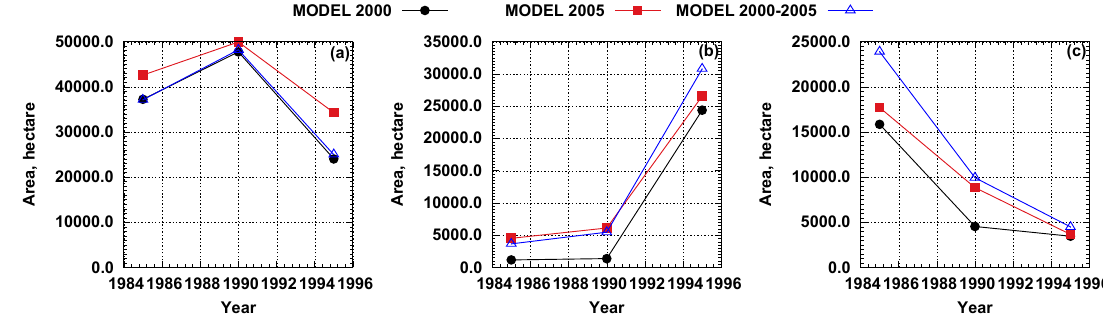
Figure 8. Predicted crop planted area for spring wheat ( a ), soybean ( b ), and combined fallow, idle, grassland, other hay types ( c ). Models capture the representative trends in crop-conversion.